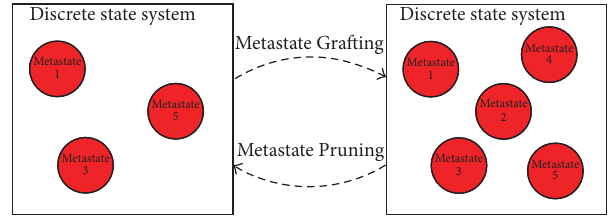
Figure 7: Example of metastate modification: Left → right shows Metastate Grafting. Right → left shows Metastate